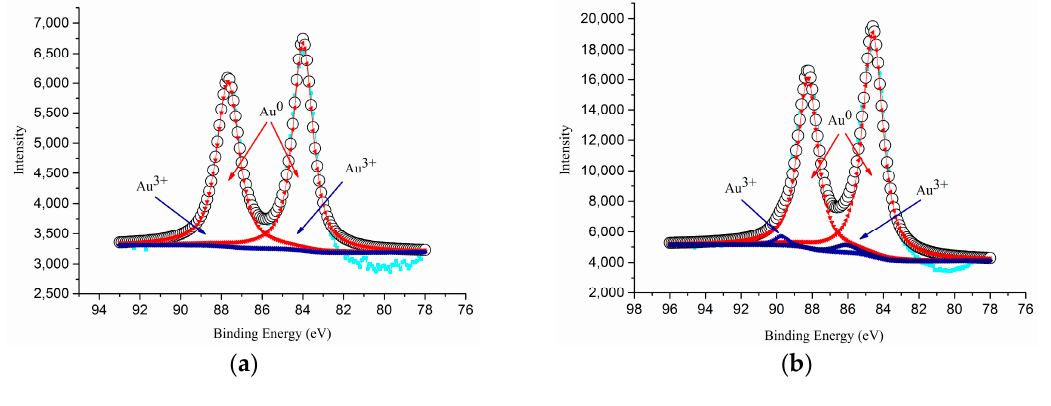
Figure 6. XPS spectra of ( a ) AS(410), and ( b ) RS(365).